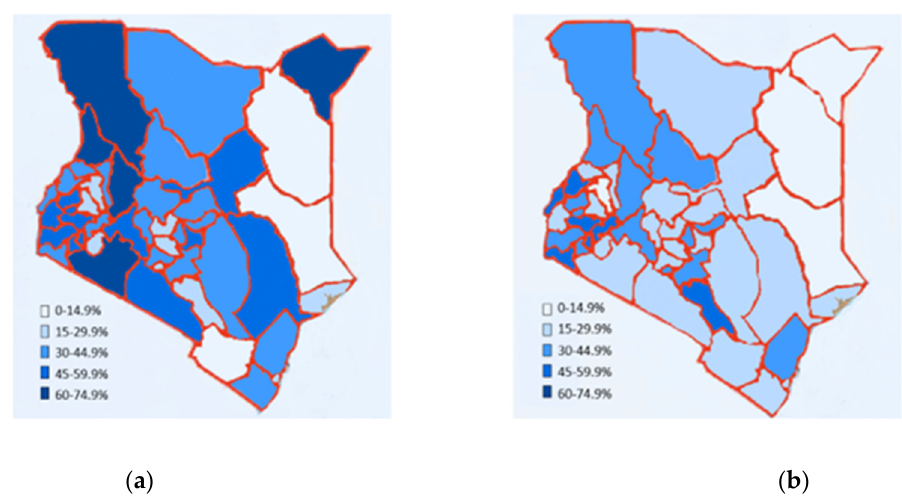
Figure 1. Prevalence of Interpersonal Violence per County in the Demographic and Health Surveys (DHS) Survey Years: ( a ) 2008; ( b ) 2014.